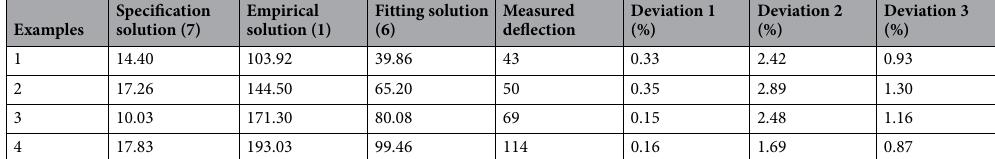
Table 4. Comparison of mid-span pre-camber (mm). Deviation 1 = specification solution/measured deflection × 100%; deviation 2 = empirical solution/measured deflection × 100%; deviation 3 = fitting solution / measured deflection ×